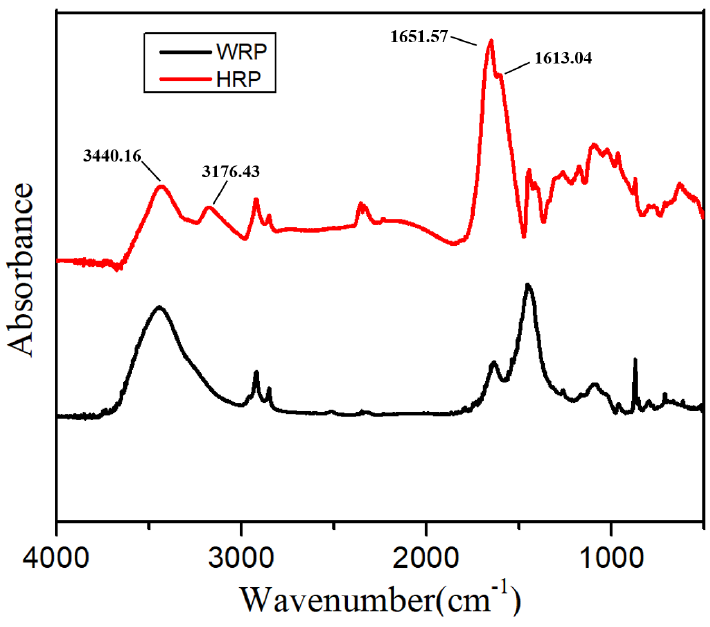
Figure 2. FTIR spectra of WRP and HRP.